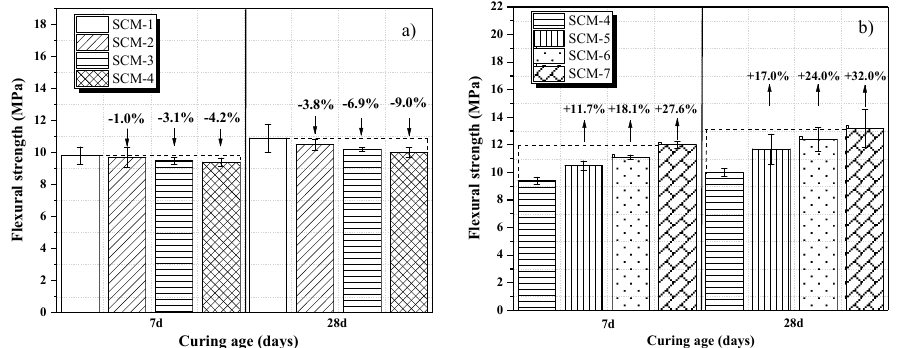
Figure 5. Results of flexural strength tests of SCM samples at varying ( a ) coral sand replacement rates and ( b ) PVA fiber contents.